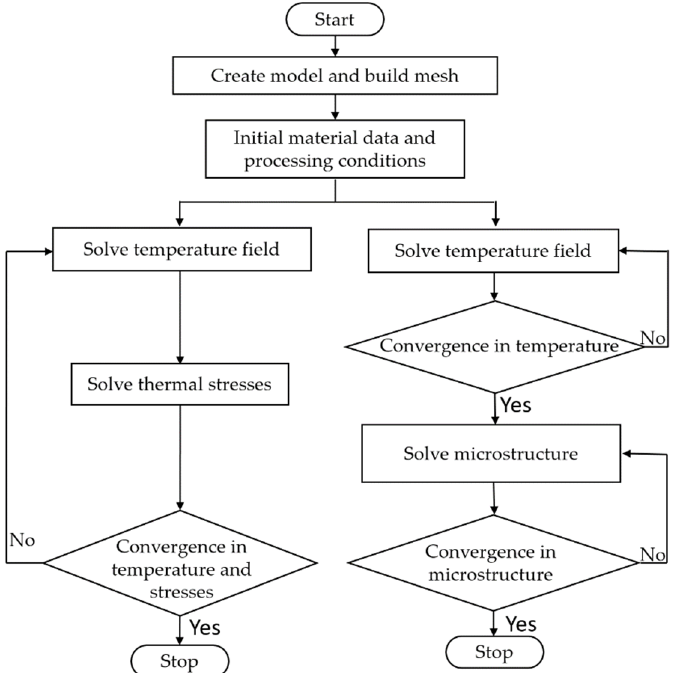
Figure 2. Flow chart of the numerical solution procedure adapted for modeling the solidification process of MMCs.